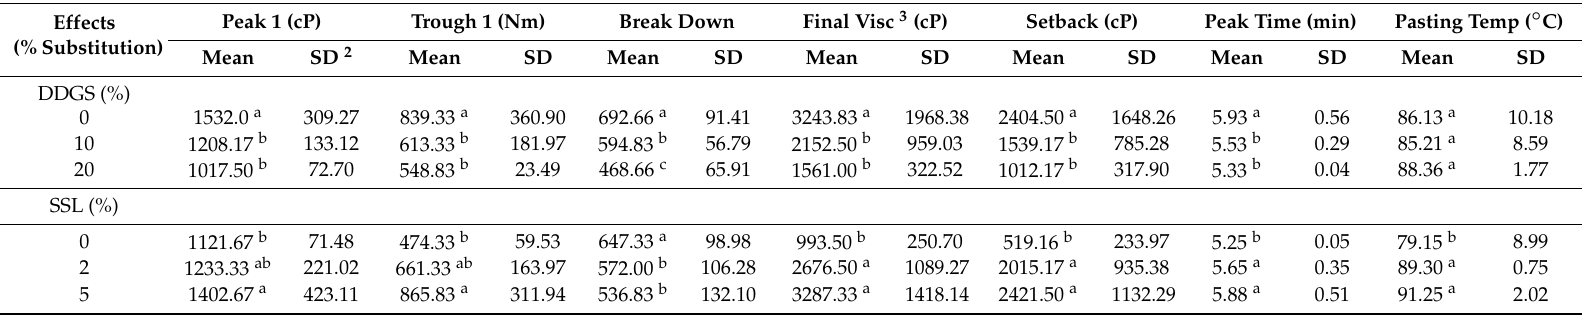
Table 9. Main effects on RVA operational parameters 1 .